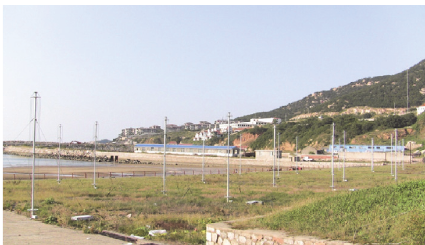
Figure 2: Receiving antenna arrays.